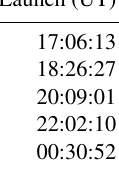
period DoRIS was in operation from 17:00 (14 March) to 11:30 UTC (15 March), both with daytime and nighttime